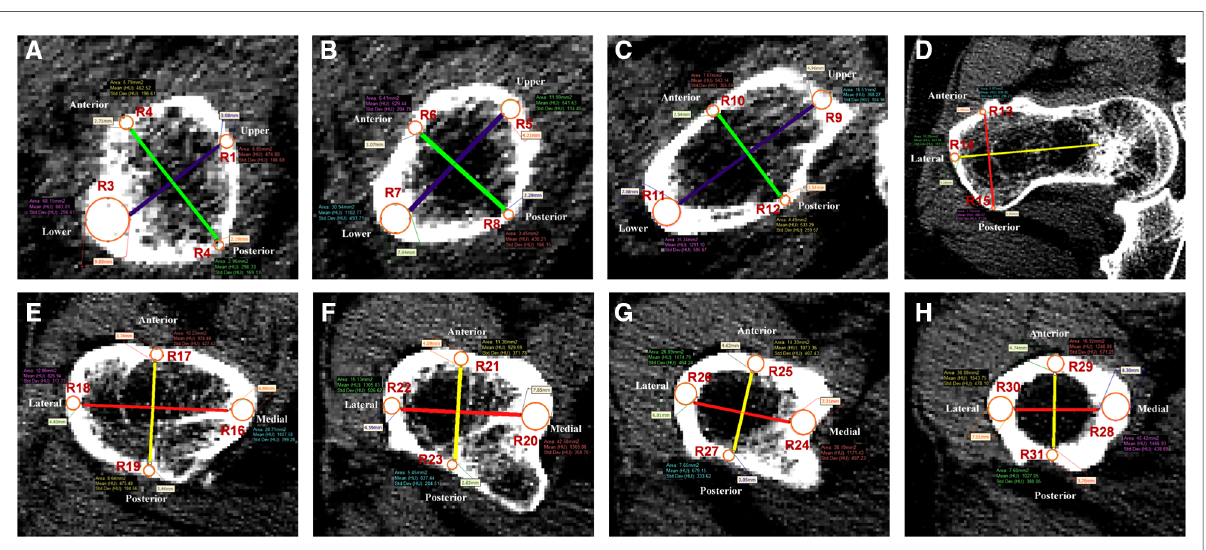
FIGURE 3 Thirty-one regions of interest were de fi ned in the femoral neck and shaft regions. ( A – C ) Femoral neck region. Purple line was the longest diameter between the upper and lower walls of femoral neck. Green line was the longest diameter between the anterior and posterior walls of femoral neck. R1 – 12 were de fi ned as the measurement points of S1 – 3. ( D – H ) Femoral shaft region. Red line was the longest diameter between the medial and lateral walls of the femoral shaft. Yellow line was the longest diameter between the anterior and posterior walls of the femoral shaft. R13 – 31 were de fi ned as the measurement points of S4 –